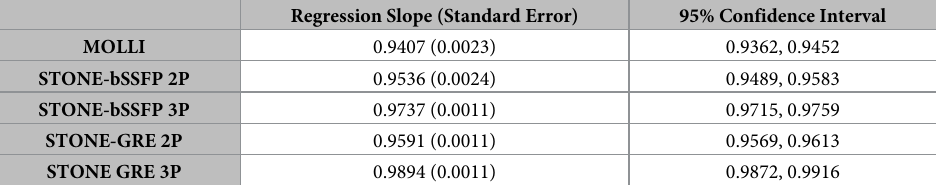
Table 3. Linear regression analysis of slice-interleaved T 1 mapping sequences against reference SE T 1